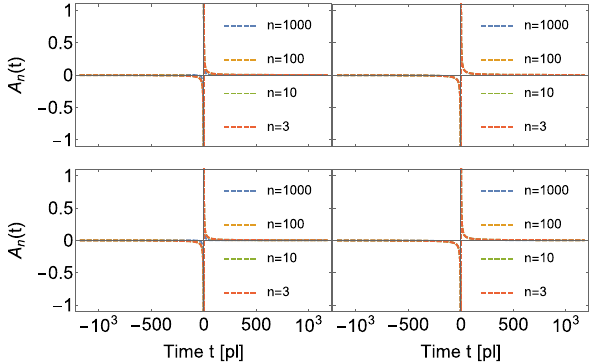
Fig. 2 Behaviour of the functions A n ( t ) around the bounce, t = 0, for differentwavenumbers n andinitialconditions,inthecaseofaquadratic potential. top left: evolution from the IC {− 0 . 99 , + 1 } , top right: